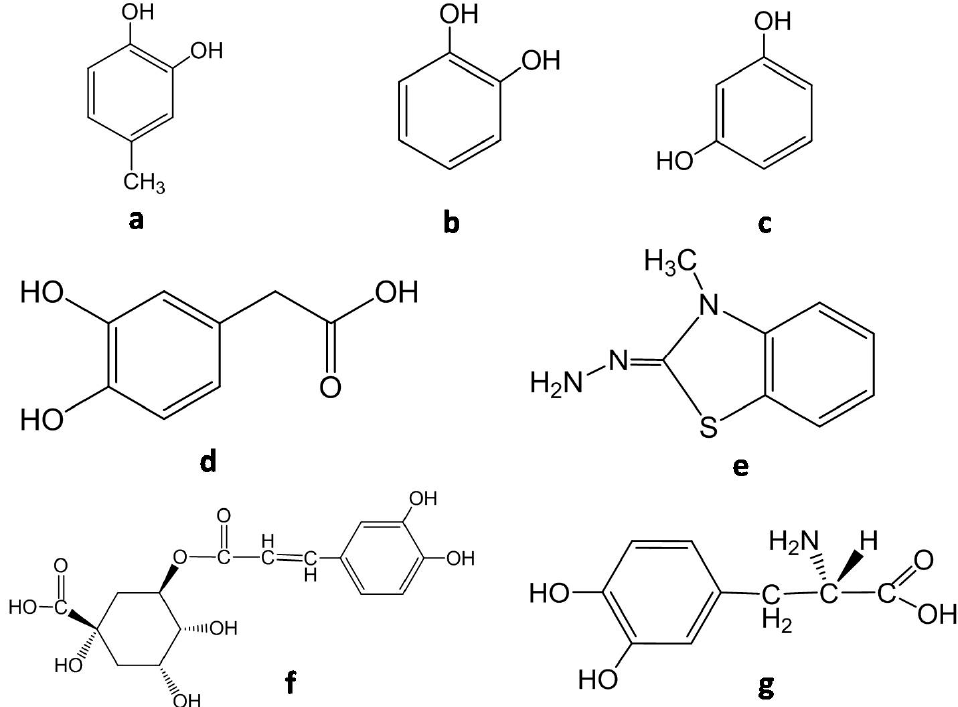
Figure 6. Molecular structures of some common subtracts used in PPO activity determination for fresh ‐ cut produce: ( a ) 4 ‐ methylcatechol; ( b ) pyrocatechol (catechol); ( c ) resorcinol; ( d ) DOPAC; ( e ) MBTH; ( f ) chlorogenic acid; ( g ) L ‐ DOPA.